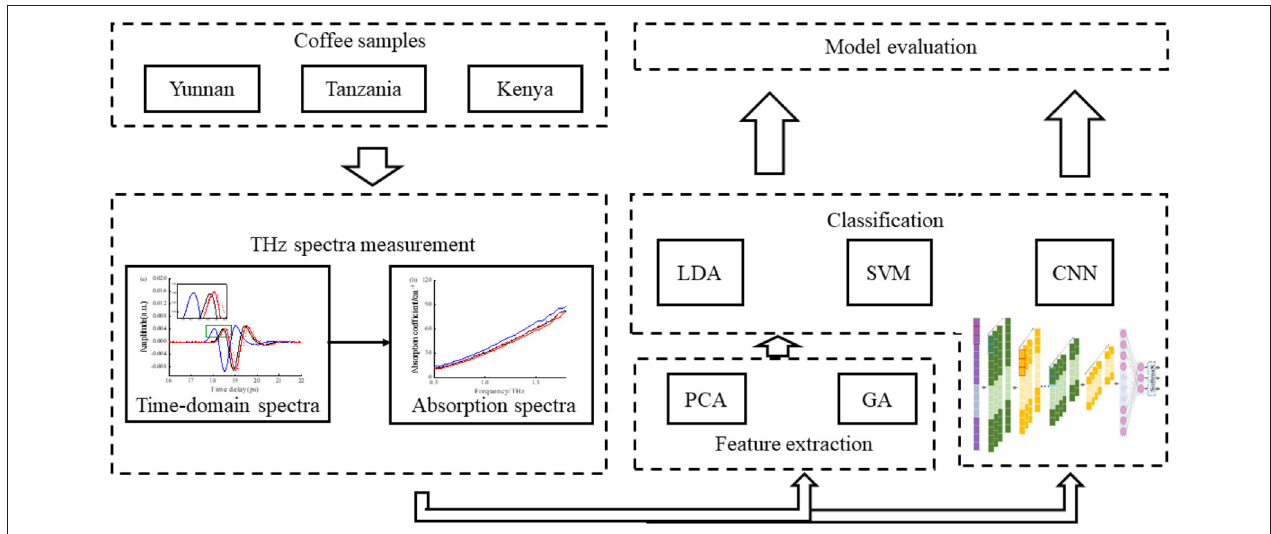
FIGURE 1 | Main steps of classifying geographical origin of coffee